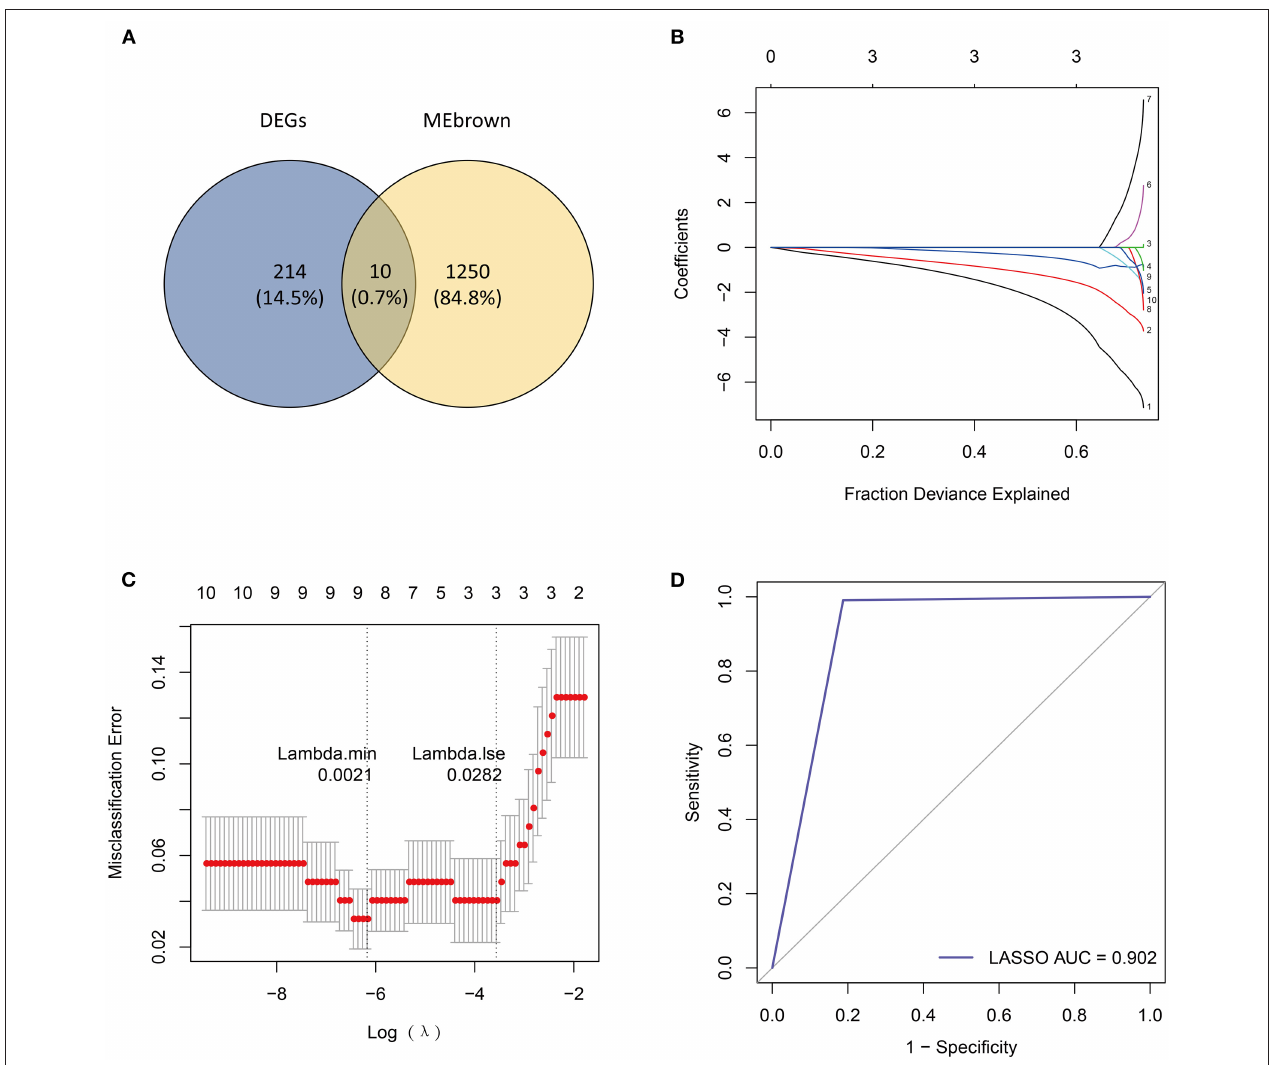
FIGURE 4 | Identification of candidate genes by LASSO regression model. (A) Venn diagram of 10 overlapped candidate genes shared by DEGs and MEbrown module. (B) LASSO coefficient profiles of candidate genes. (C) Cross-validation to select the optimal tuning parameter log (Lambda) in LASSO regression analysis. (D) ROC curve evaluation of LASSO regression